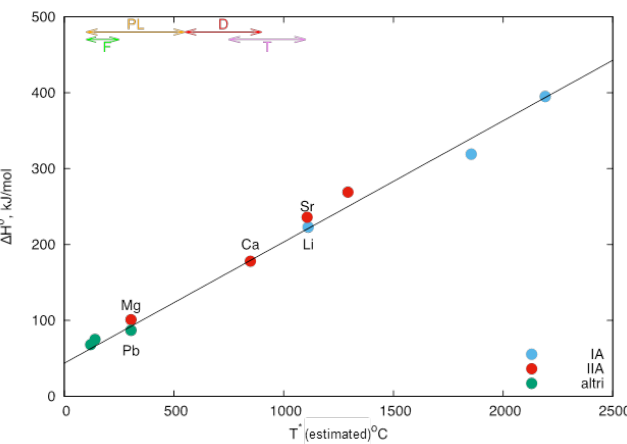
Figure 8. Heat of reaction vs. estimated turning temperature for different metal oxides systems, with indication of the operating temperature ranges for the main CST technologies: Fresnel (F), Parabolic trough (PL), Dish (D), Solar Tower (T).